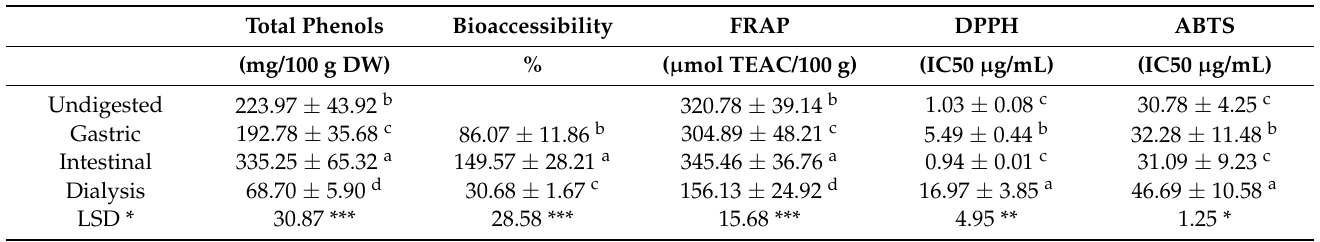
Table 6. Antioxidants and total phenol activity of in vitro digested and fermented cowpea leaf smoothies from VOP 1 cowpea